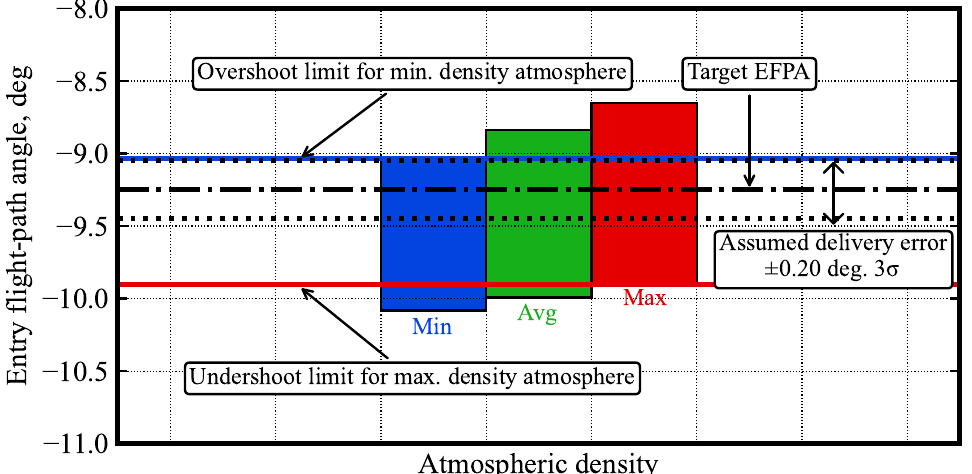
Figure 8. Effect of density variation on Mars aerocapture corridor bounds. The black dash-dot line indicates the selected EFPA, and the black dotted lines indicate the assumed ± 3 σ delivery